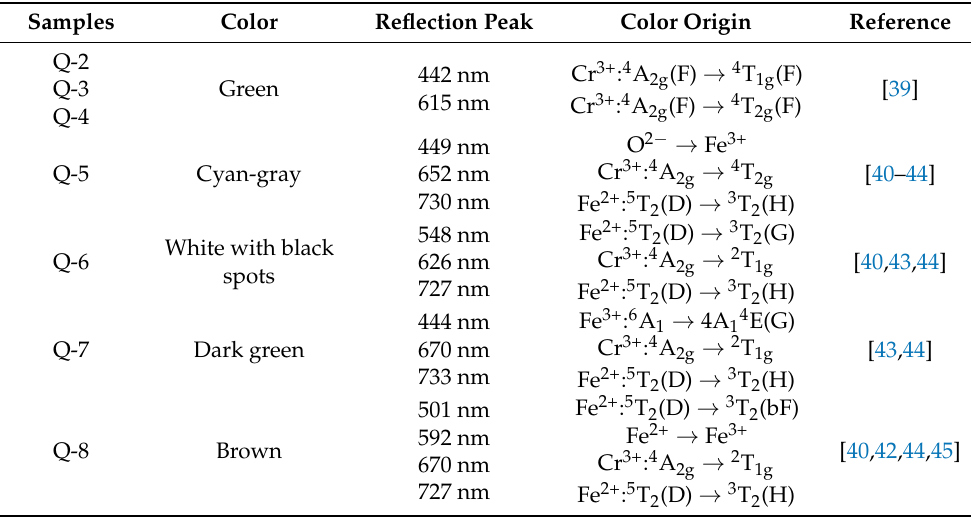
Table 7. The origins of color for the Philippines rock